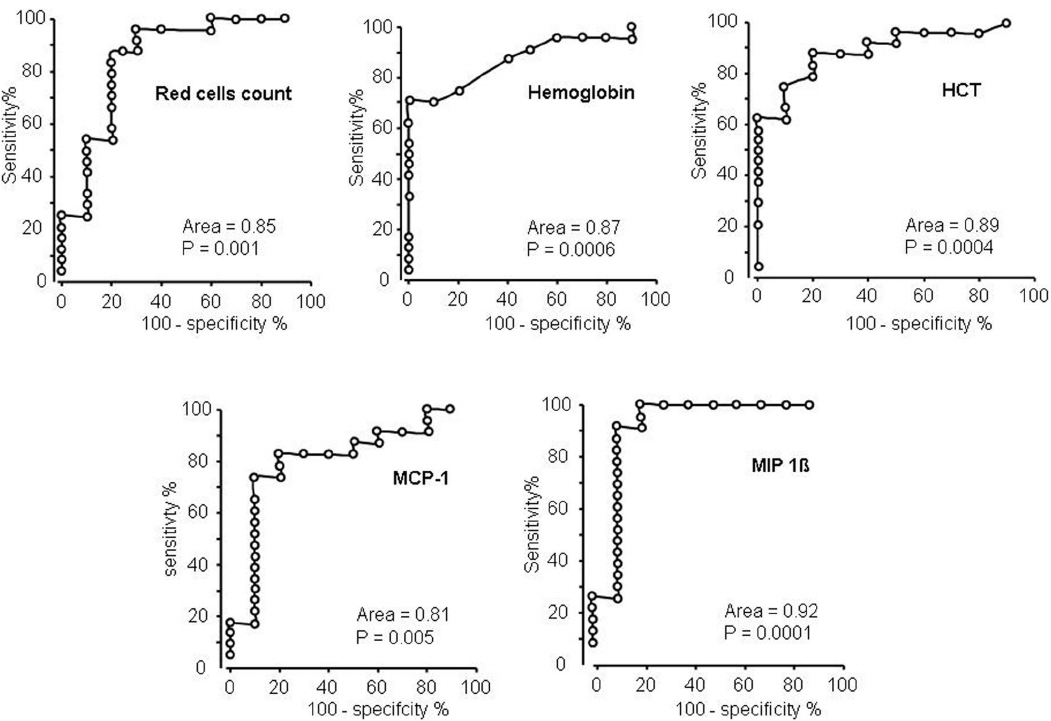
Figure 2. ROC analysis indicating that red blood cells, Hemoglobin, HCT, MCP-1 and MIP-1ß values significantly discriminate proliferating-IH samples (age # 12 months) from regressing -IH samples ( . 12 months